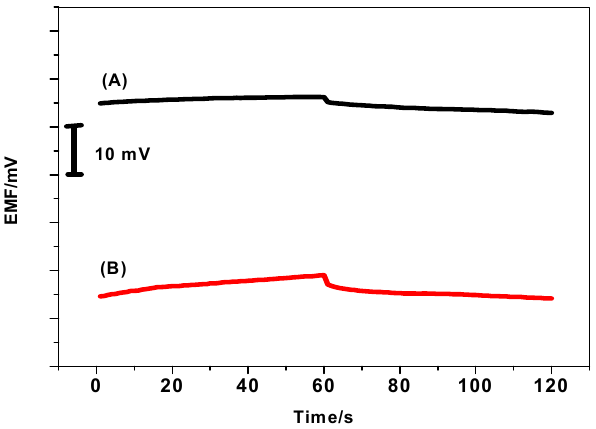
Figure 8. Chronopotentiometry for DCP/MIP-ISEs (A) with and (B) without PANI as a solid contact material.